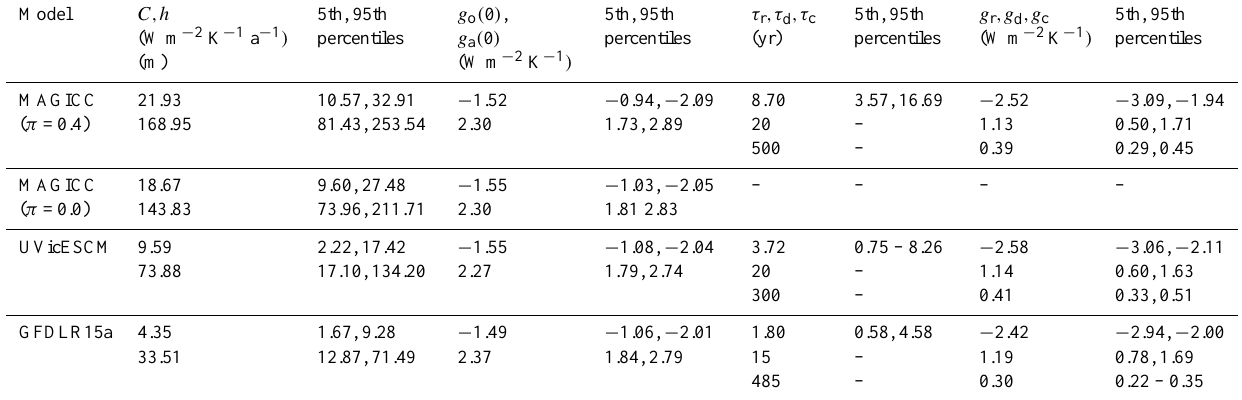
Table 1. Estimates of various parameters derived from the relationships shown Fig. 4 (see text for explanation). The values of τ d , c are the median values of the distributions shown in Fig. 3a and g d , c are the areas under the distribution function. Note, − g o ( 0 ) = g d + g c . The 95 percent confidence intervals are derived from the 100 member ensemble of the simulated annealing